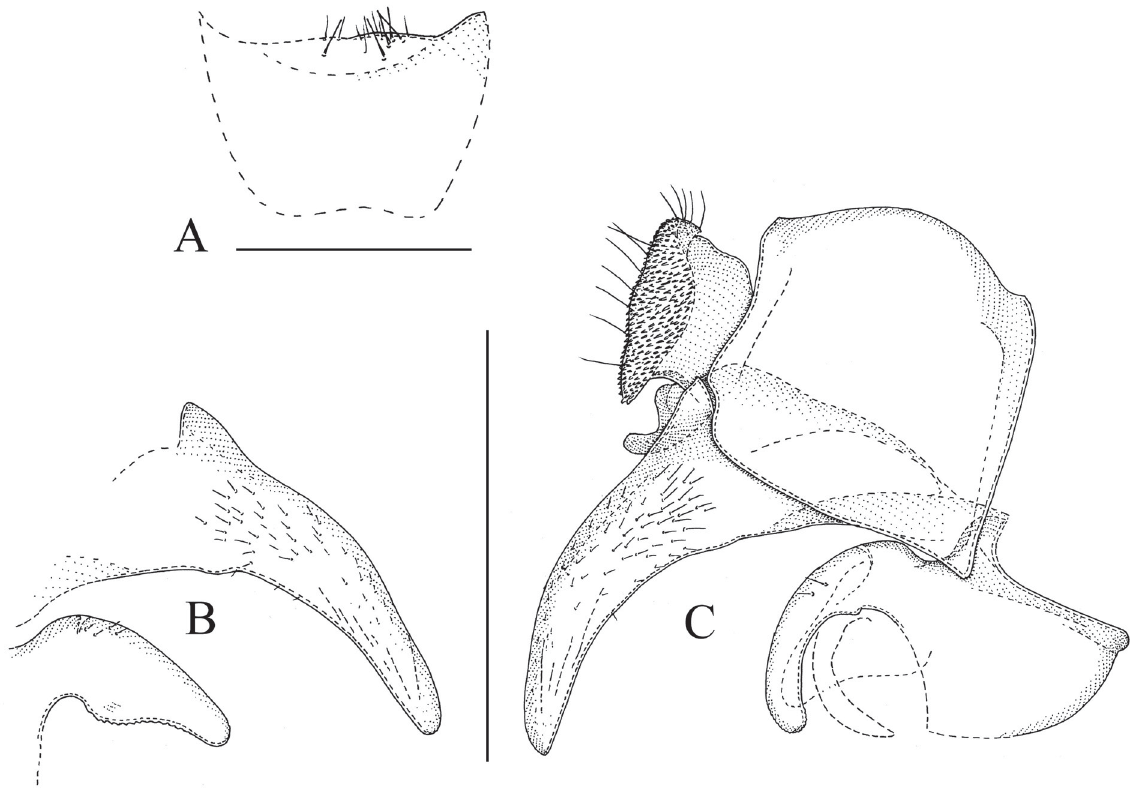
Fig. 18. Sphegina (Asiosphegina) brevipilis sp. nov., holotype, ♂ . A . Sternum IV, ventral view. B . Posterior part of genitalia, left side, lateral view. C . Genitalia, right side, lateral view. Scale bars = 0.5